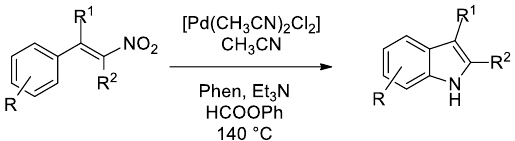
4 of 10 Figure 1. Indoles from o -nitrostyrenes. Conditions A: 0.27 mmol nitrostyrene, mol. 1 mol % [Pd(Phen) 2 ][BF 4 ] 2 , 1 mol % Ru 3 (CO) 12 , 20 mol % Phen; mol. 40 µL (0.29 mmol) Et 3 N; in butyl formate (10 mL), at 180 °C for 10 h. Conditions B: 0.54 mmol nitrostyrene, 1 mol % Pd(CH 3 CN) 2 Cl 2 , 2.5 mol % Phen, 240 µL (2.2 mmol) HCOOPh, 40 µL (0.29 mmol) Et 3 N, in CH 3 CN (10 mL), 140 °C for 3 h (unless otherwise noted). Conditions C: 0.54 mmol nitrostyrene, 1 mol% Pd(CH 3 CN) 2 Cl 2 , 5 mol% Phen, 260 µL (2.38 mmol) HCOOPh, 100 µL (0.72 mmol) Et 3 N, in CH 3 CN + DMF (9+1 mL), at 100